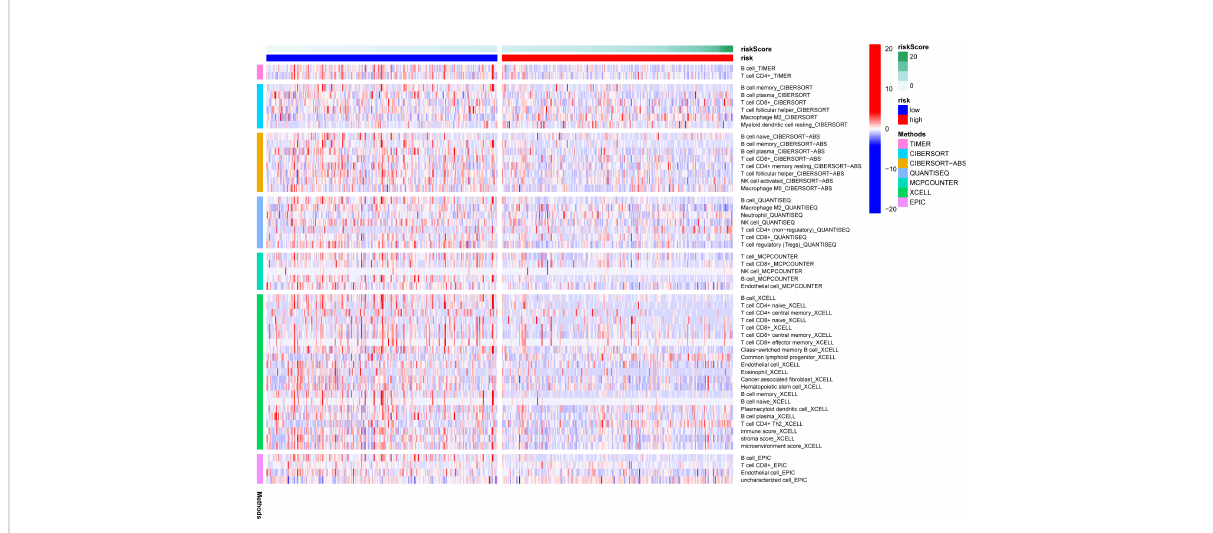
FIGURE 6 Comparison of immune analysis between both risk groups. The ESTIMATE, TIMER, MCP counter and CIBERSORTx algorithms were used to compare the cellular components or cell immune responses between the high- and low-risk groups. ns, not signi fi cant.